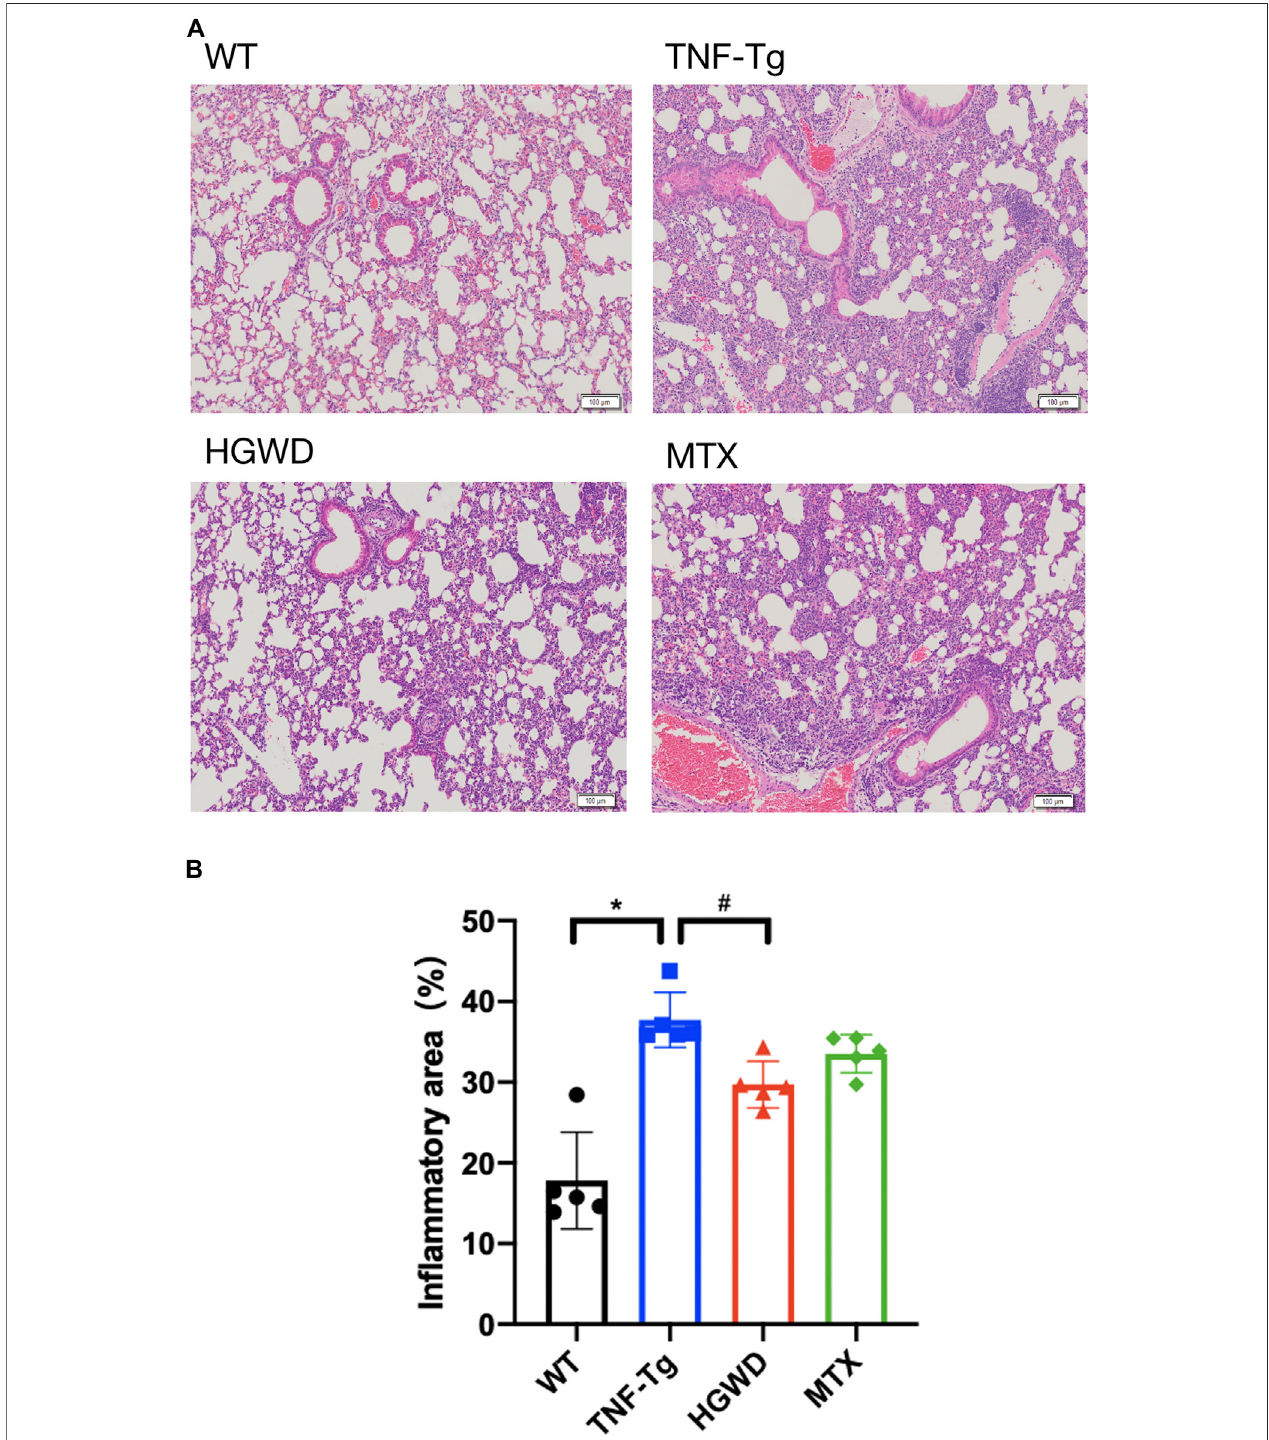
FIGURE 6 | HGWD reduces lung in fl ammation in fi ltration in TNF-Tg mice. (A) TNF-Tg mice showed severe in fl ammatory in fi ltration near the lung bronchi, and the alveolarintervalwassigni fi cantlythickened.TheHGWD-treatedmicehadreducedlungin fl ammationin fi ltration,andthealveolarintervalwassmallerthanthatintheTNF- Tggroup.Bar=100 μ m. (B) Quanti fi cationoflungin fl ammationin fi ltrationarea.ValuesarethemeanplusorminusSDof5lungsineachgroup.* p < 0.05,comparedwith WT group; # p < 0.05, compared with TNF-Tg group.